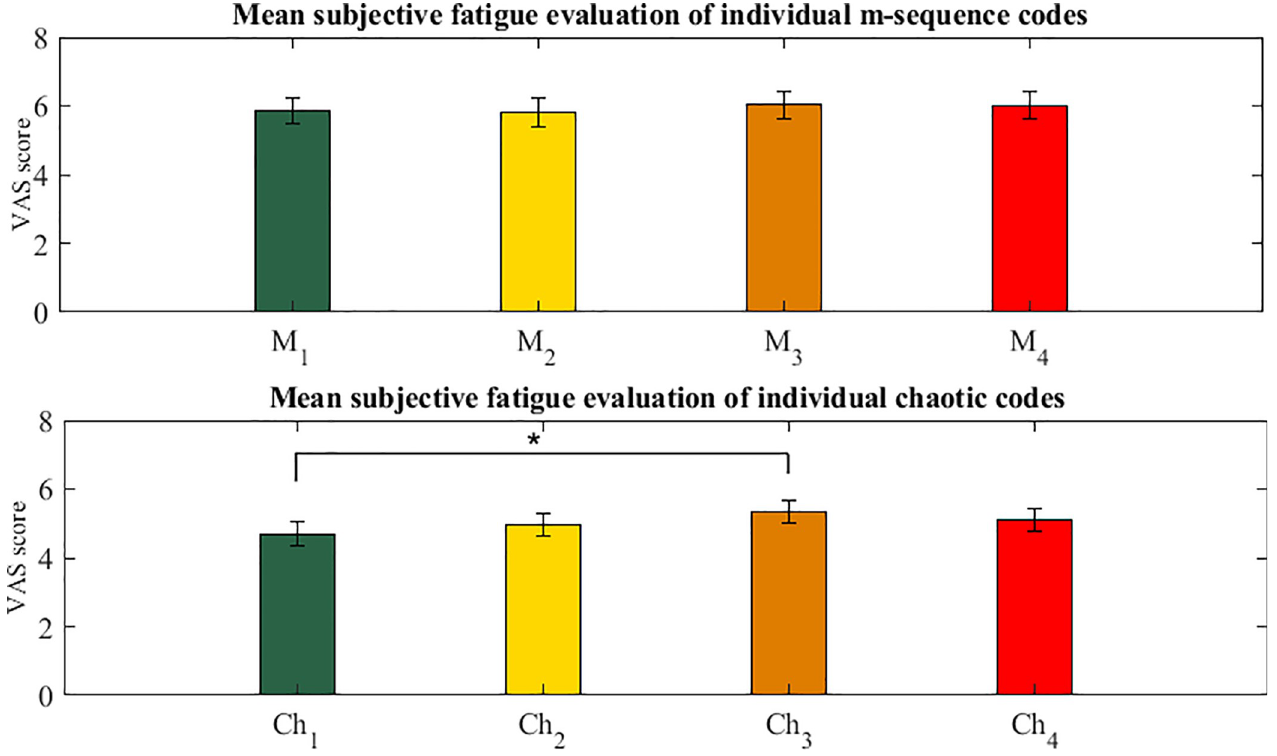
Fig 16. Subjective fatigue scores of individual m-sequence and chaotic codes. There was significant difference between VAS score of chaotic codes Ch 1 and Ch 3 (for each code n = 44 and � p =